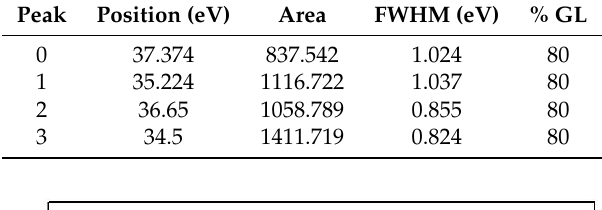
Table 2. Peak-fitting results of W 4f XPS spectra of the catalyst.